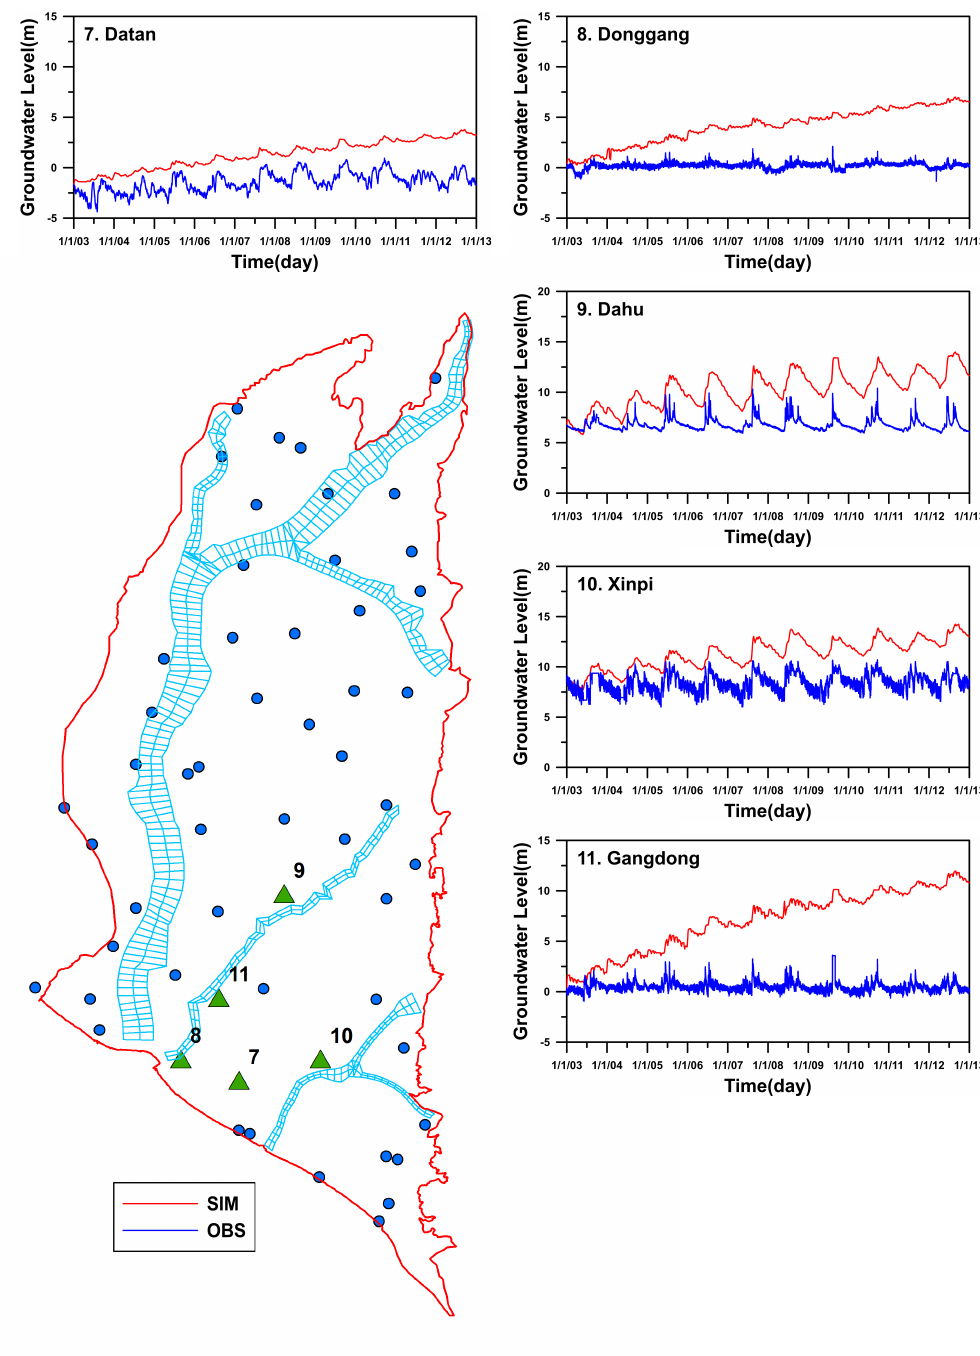
Figure 11. As in Figure 10, but for the downstream of the Donggang and Linbian